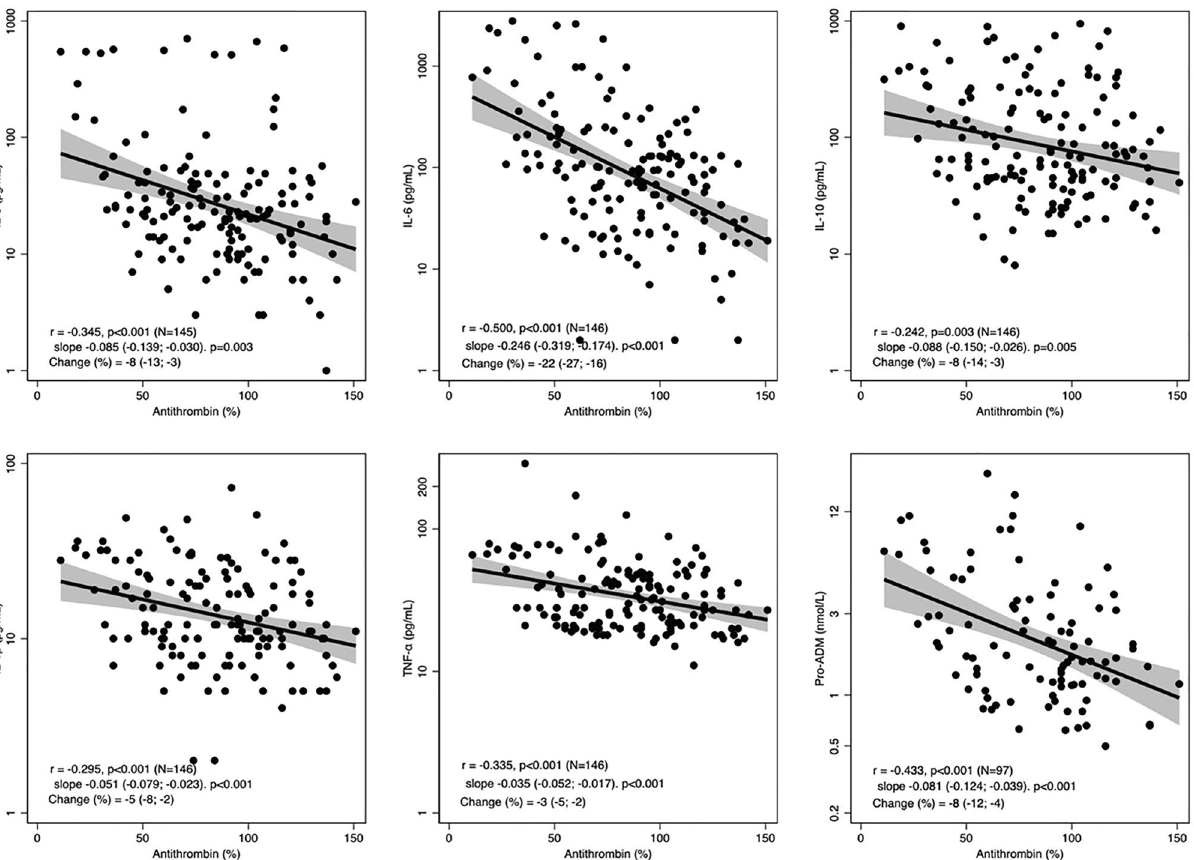
Figure 3. Correlation between cytokines and antithrombin. Pearson’s correlation coefficients, regression slopes and percent change in cytokine for 10% increase in antithrombin plasma level (%) with 95% CI from random- intercept linear regression